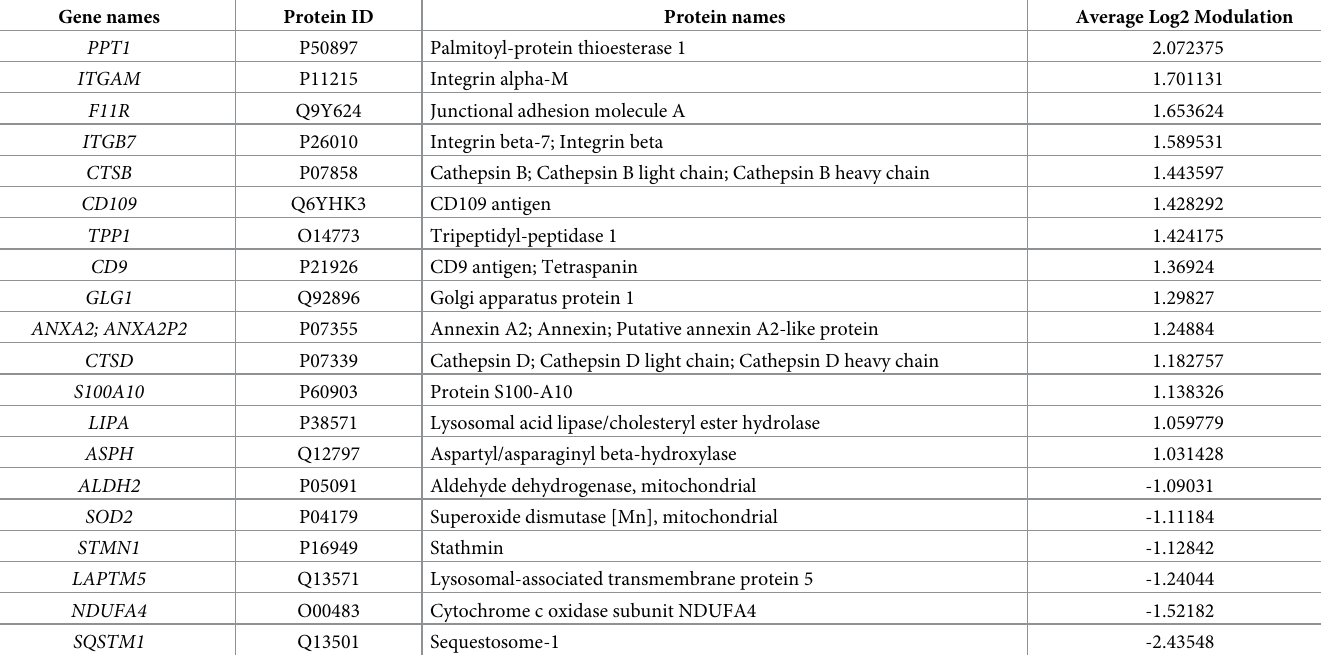
Table 3. Twenty most modulated autophagosome-associated proteins in Leishmania -infected compared to starved dTHP-1.